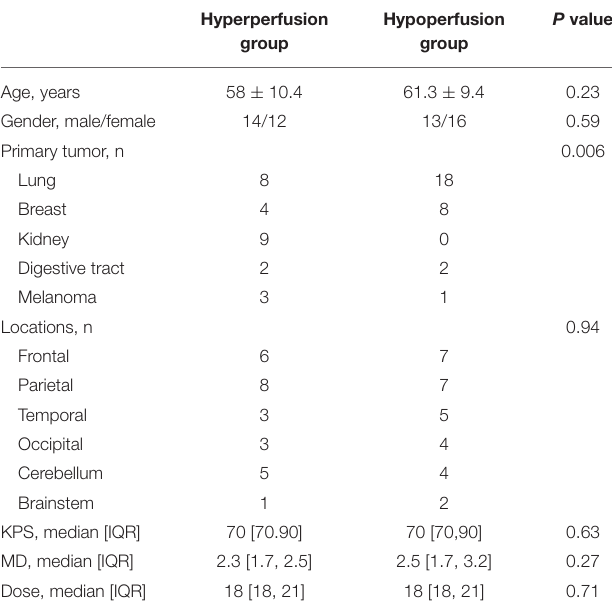
TABLE 1 | The summarized information of all enrolled populations.